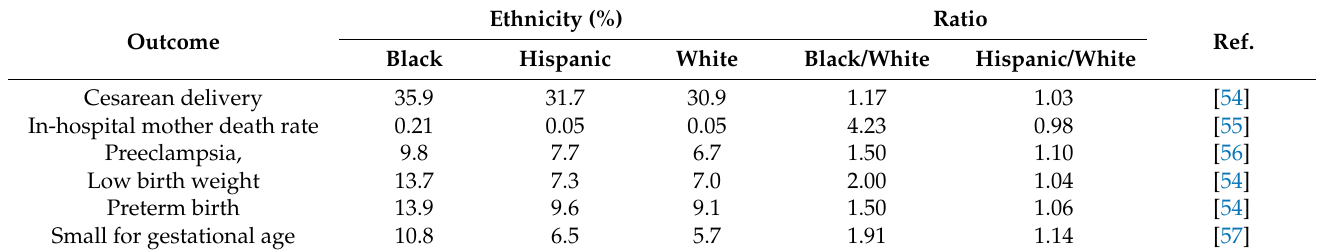
Table 1. Pregnancy and birth outcomes as a function of ethnicity.